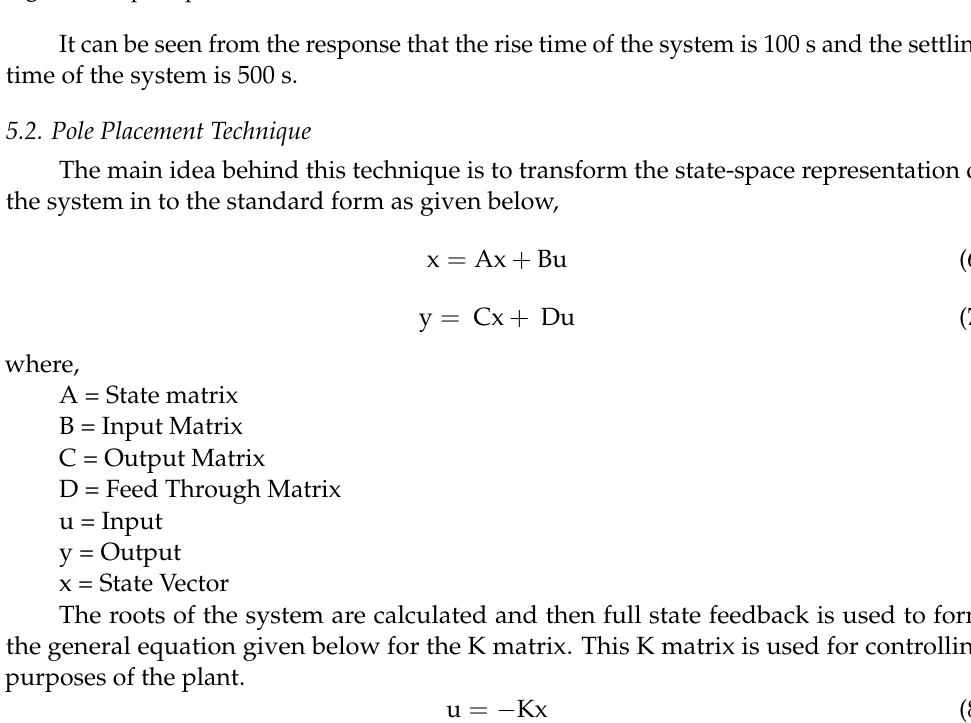
Figure 8. Step Response with PI controller.